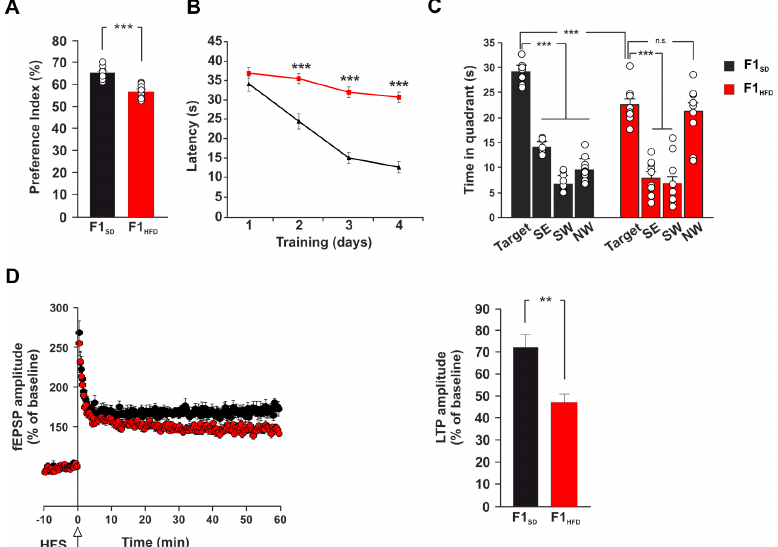
Figure 1. Maternal HFD anticipates the onset of learning and memory deficits in 3xTg-AD mice. ( A ) Preference for the novel object of offsprings derived from female 3xTg-AD mice fed SD or HFD (F1 SD or F1 HFD , respectively) (n = 10 for each group; statistics by unpaired Student’s t-test). ( B ) Latency to reach the platform in MWM test (n = 10 for each group; statistics by unpaired Student’s t-test). ( C ) Time spent in the four quadrants during MWM probe test. NE is the target quadrant (n = 10 for each group; statistics by unpaired Student’s t test for time in the target quadrant and one-way ANOVA and Bonferroni post hoc for time in all quadrants). ( D ) Time course (left) of LTP at CA3-CA1 synapses in hippocampal slices of F1 SD and F1 HFD mice. Results are expressed as percentages of baseline EPSC amplitude (=100%). On the right, mean LTP values during the last 5 min (n = 10 for F1 HFD and n = 11 for F1 SD ; statistics by unpaired Student’s t-test). Data are expressed as mean ± SEM. ** p < 0.01; *** p < 0.001; n.s. not significant.